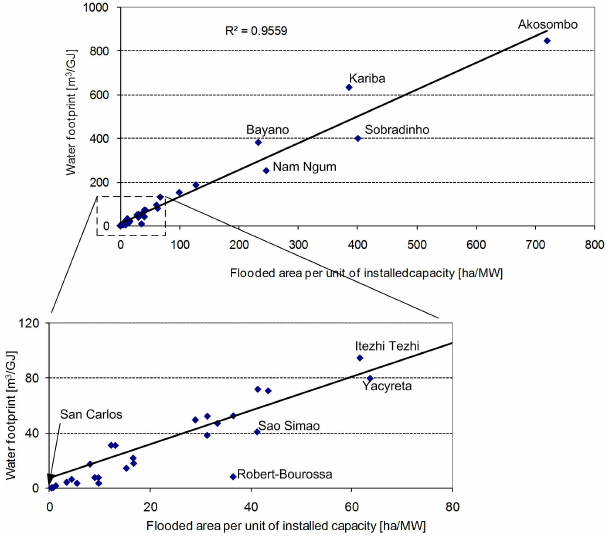
Fig. 2. Relation between the water footprint of hydroelectricity and the flooded area per unit of installed hydroelectric